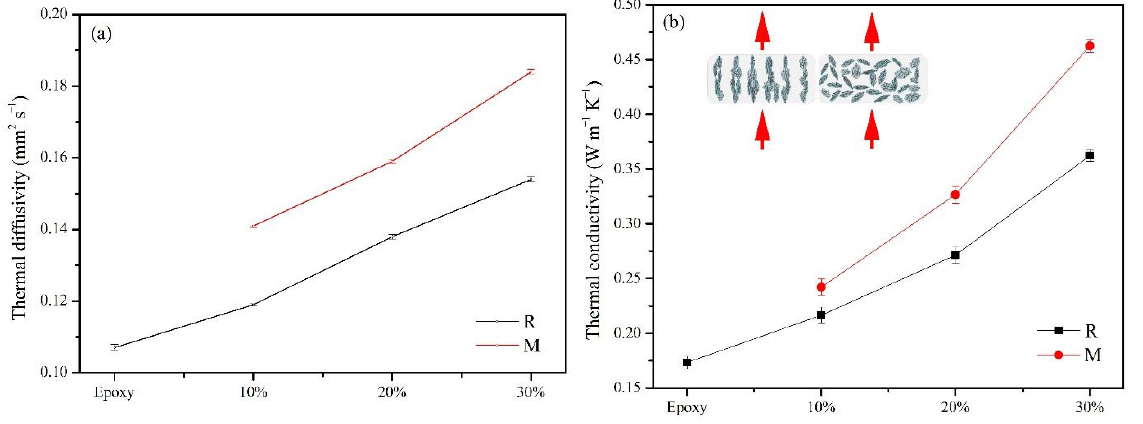
Figure 9. Thermal diffusivity ( a ) and thermal conductivity ( b ) of pure epoxy and the NiGNT–epoxy composites with different ratios.